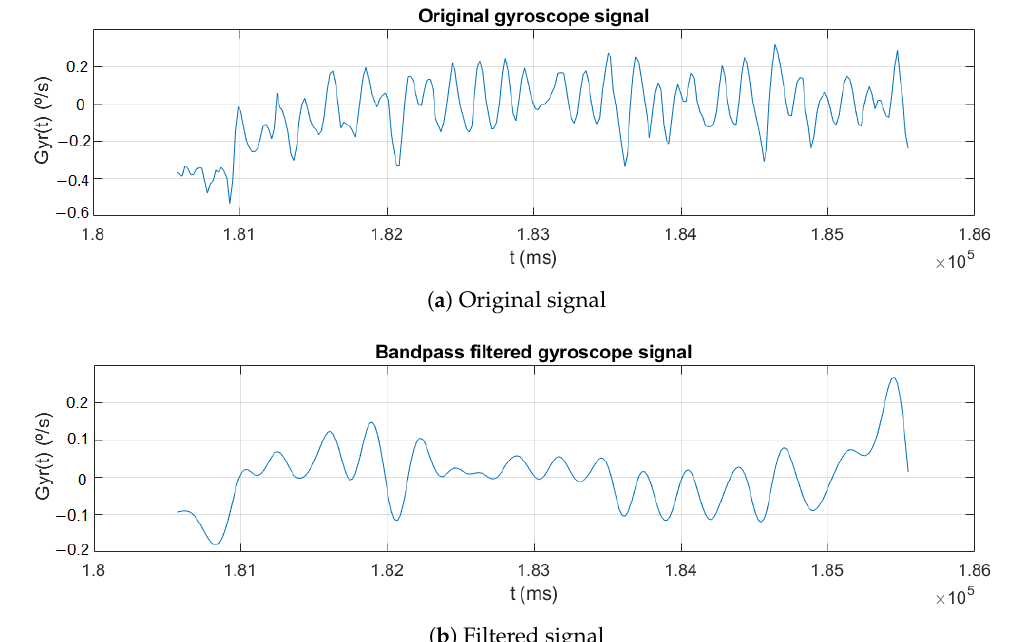
Figure 3. Filtering applied to the gyroscope signals. ( a ) sample of the original signal corresponding to exercise 4 (finger tapping); ( b ) gyroscope signal after applying a 0.25–3.5 Hz fourth-order Butterworth band pass